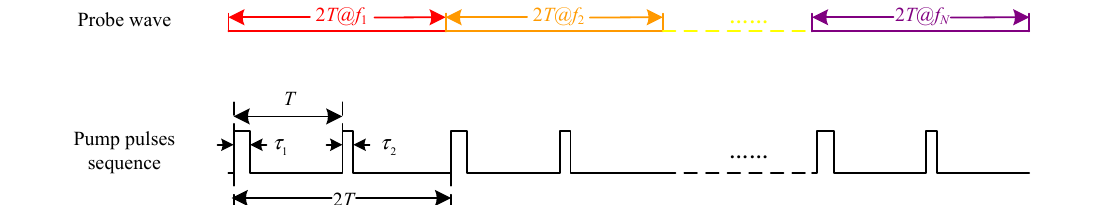
Fig. 10 Scheme of a high-spatial-resolution F-BOTDA [100].